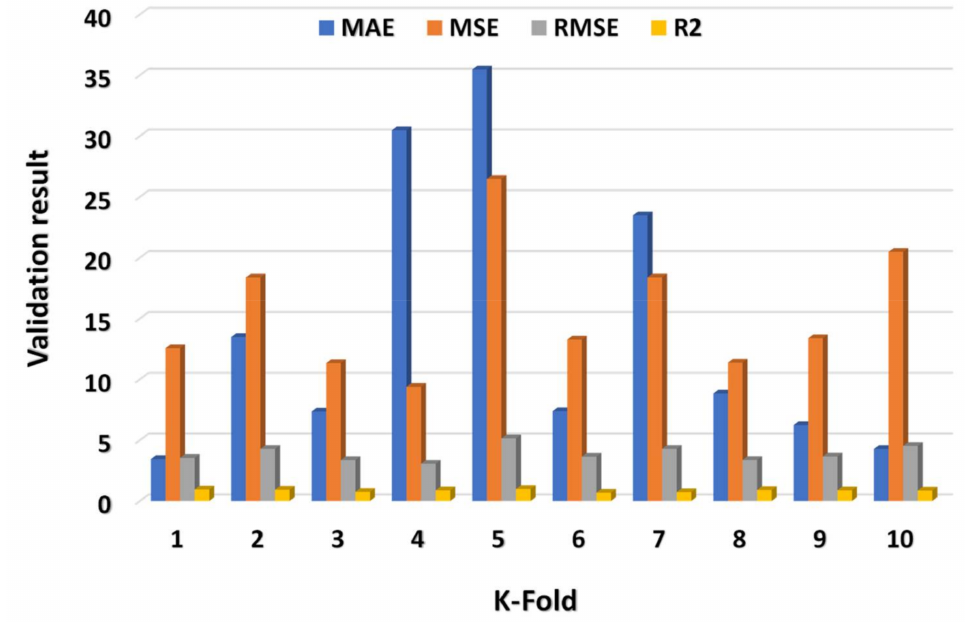
Figure 9. MLP model’s statistical explanation of CV